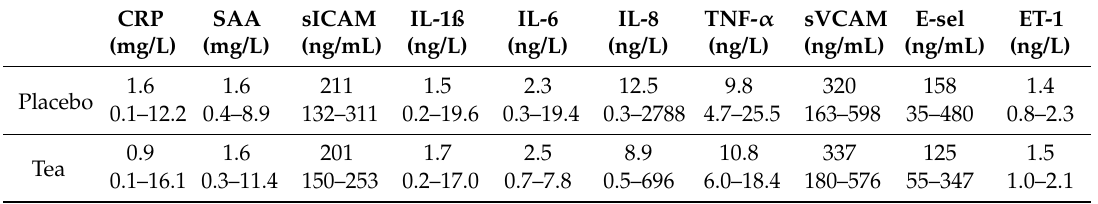
Table 3. Plasma concentrations of biomarkers of endothelial dysfunction and low ‐ grade inflammation.